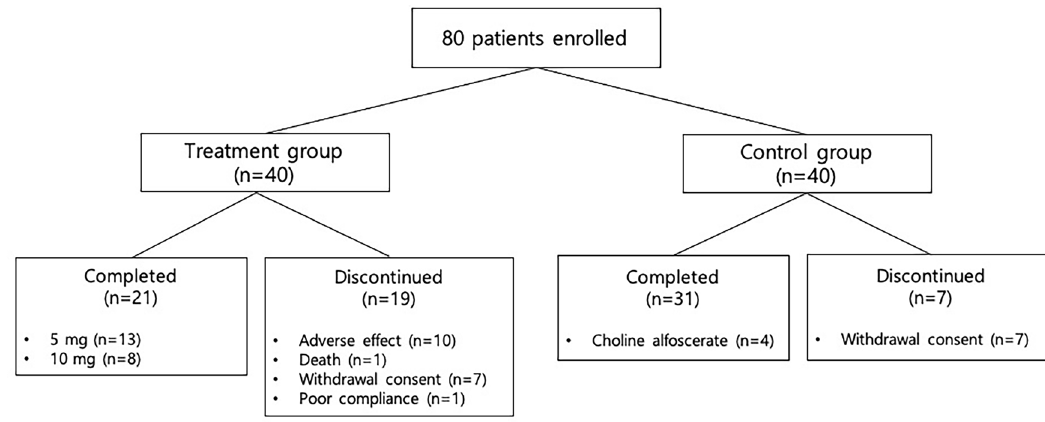
Figure 1. Patient disposition.